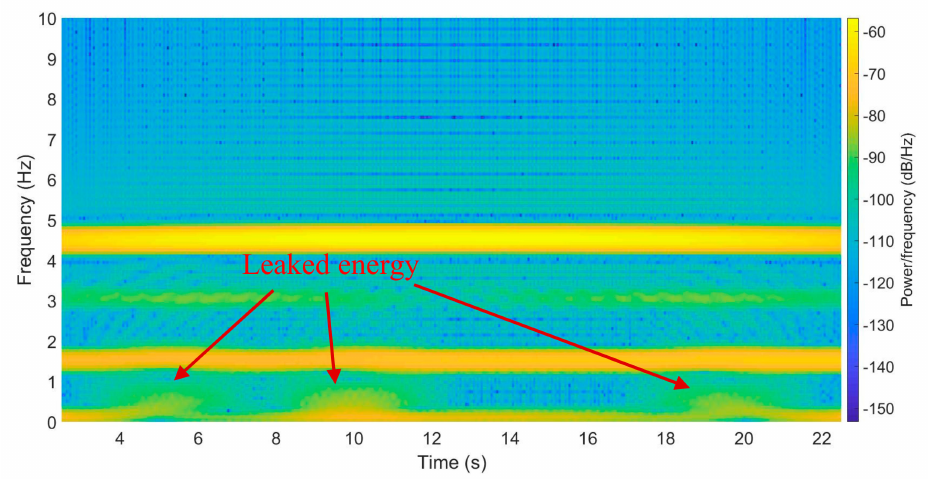
Figure 10. Comparison of STFT results of bridge accelerations with multiple